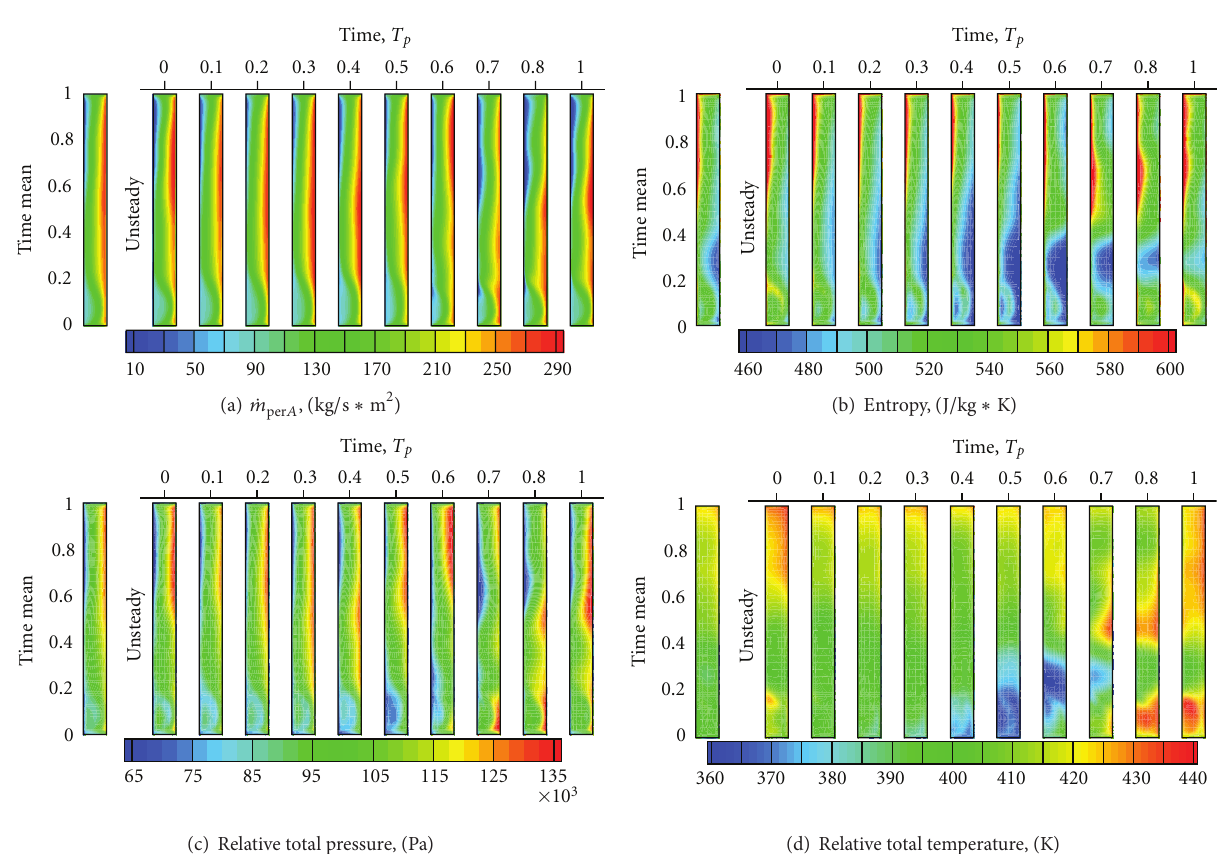
seconds rotor two span cut-plane. %